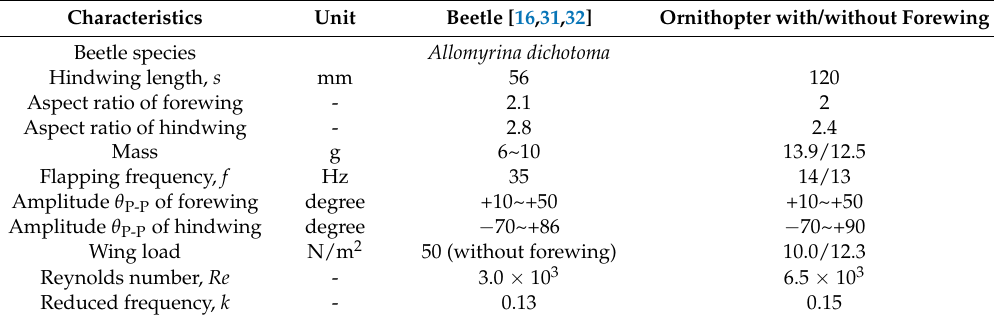
Table 2. Weight composition of the ornithopter in